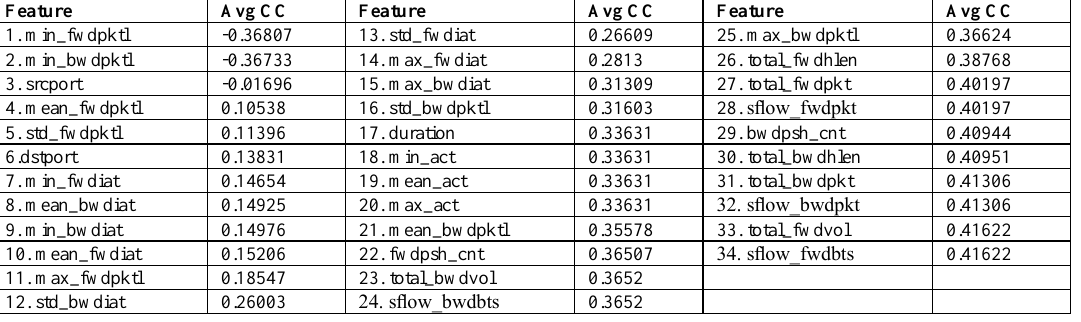
Table 4. Average correlation coefficient scores.